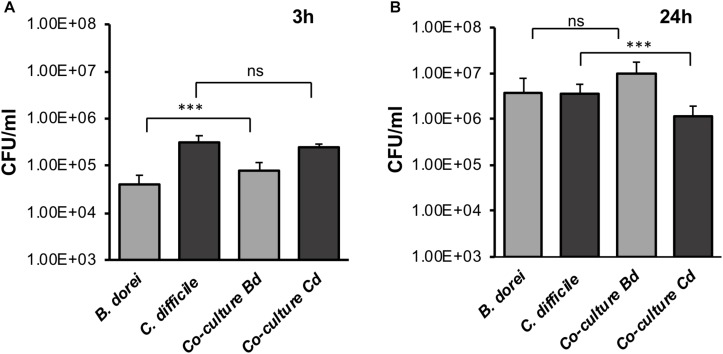
Studying C. difficile-commensal interactions within the E-VDC model. (A) Mono or mixed cultures of B. dorei and C. difficile were incubated with the epithelial monolayers in the VDCs for 3 h. Co-cultures of B. dorei with C. difficile in the VDC showed no significant reduction of vegetative C. difficile growth at 3 h p.i. as compared to C. difficile mono-culture. A relative increase in B. dorei adhering to the IECs was observed in co-cultures. “Co-culture Bd and Cd” represent the growth of B. dorei and C. difficile, respectively, in the mixed culture (Bd, B. dorei and Cd, C. difficile) on the IECs. Data shown are the mean of three independent experiments and error bars indicate SD, ***p < 0.001, ns, not significant as determined by one-way ANOVA. (B) At 24 h, a significant reduction of C. difficile CFU (vegetative cells) is observed in co-cultures compared with C. difficile mono-culture. Data shown are the mean of three independent experiments and error bars indicate SD, ***p < 0.001, ns, not significant as determined by one-way ANOVA with Tukey’s test for multiple comparison.